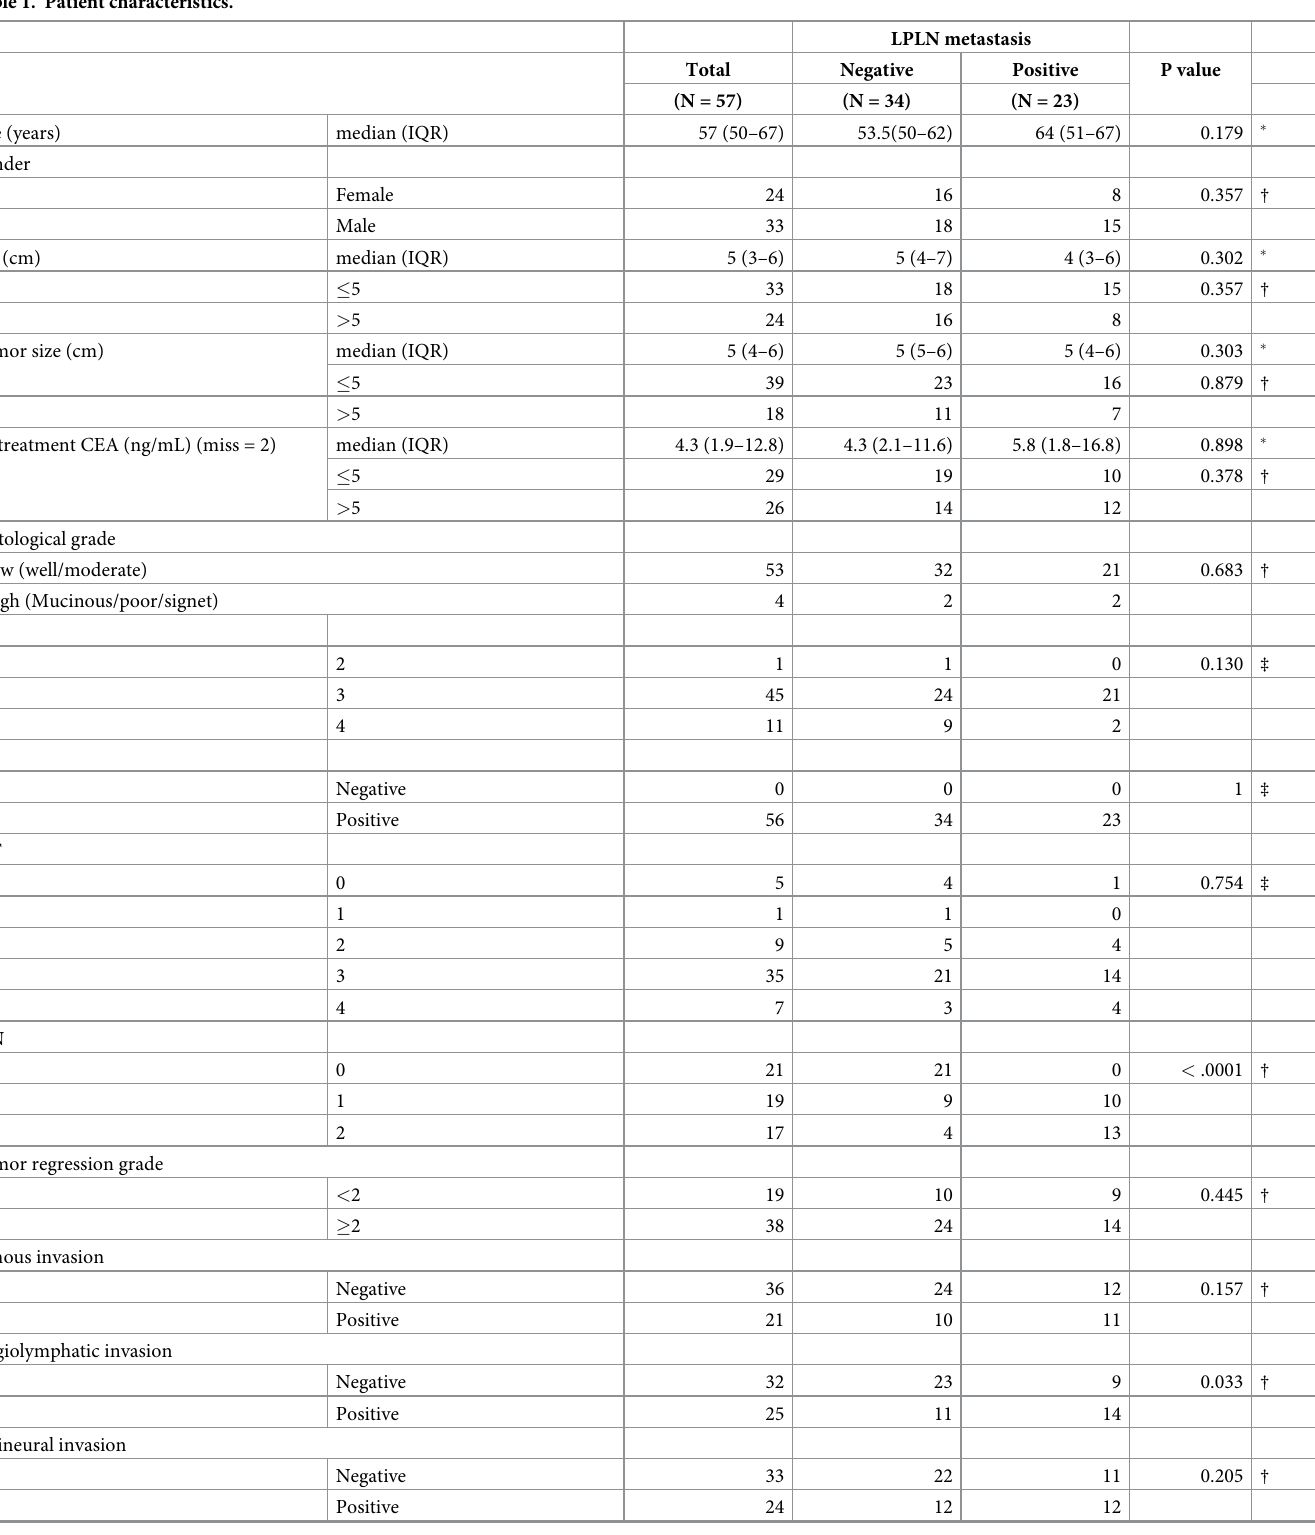
Table 1. Patient